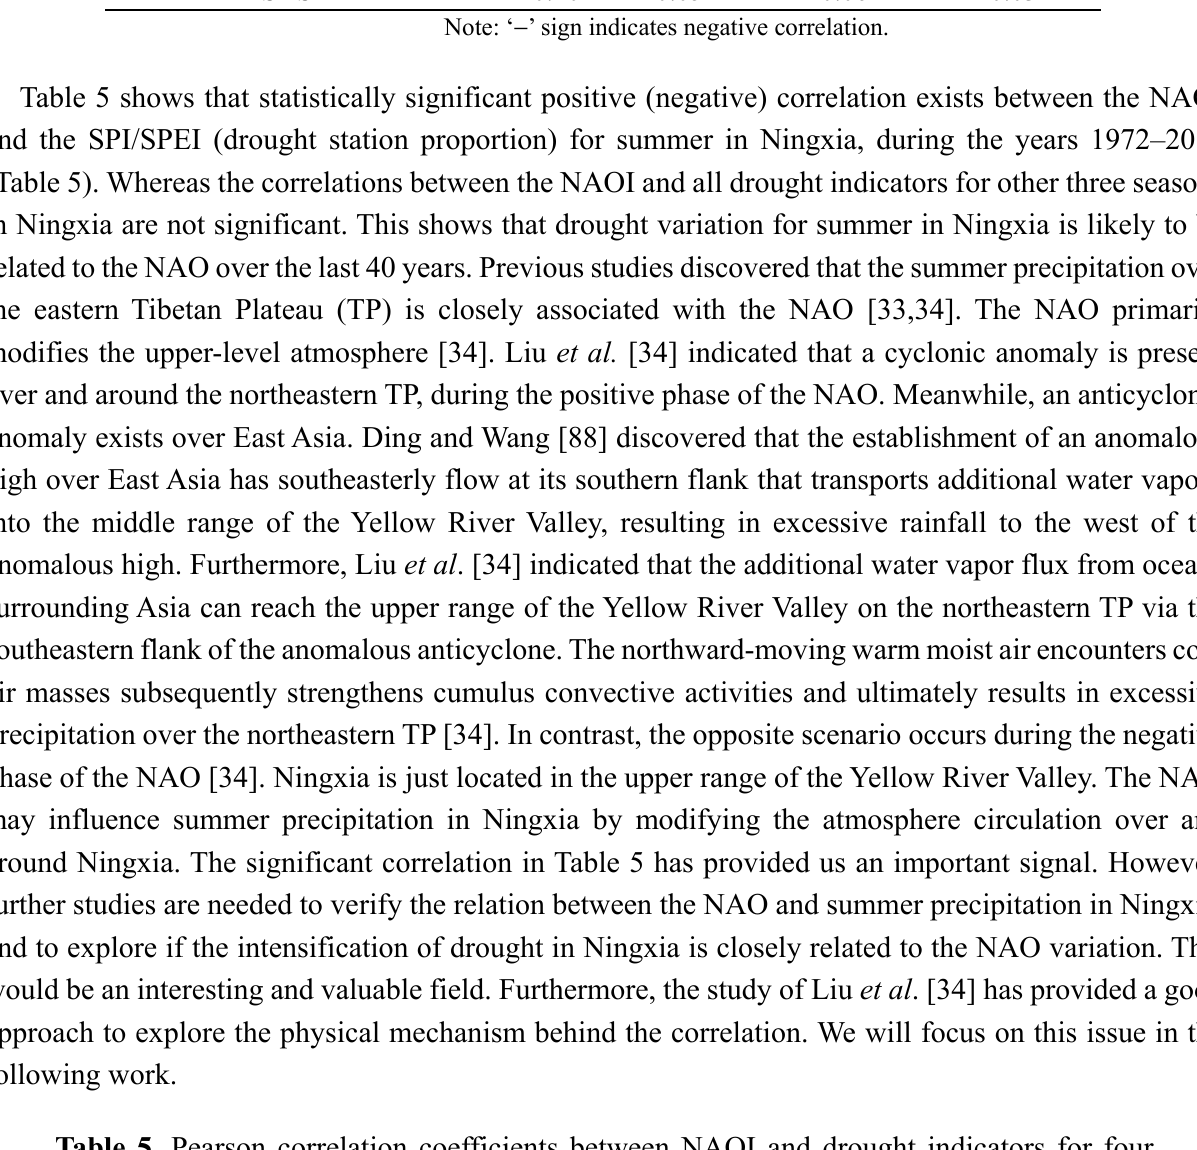
Table 5. Pearson correlation coefficients between NAOI and drought indicators for four seasons in Ningxia during the years